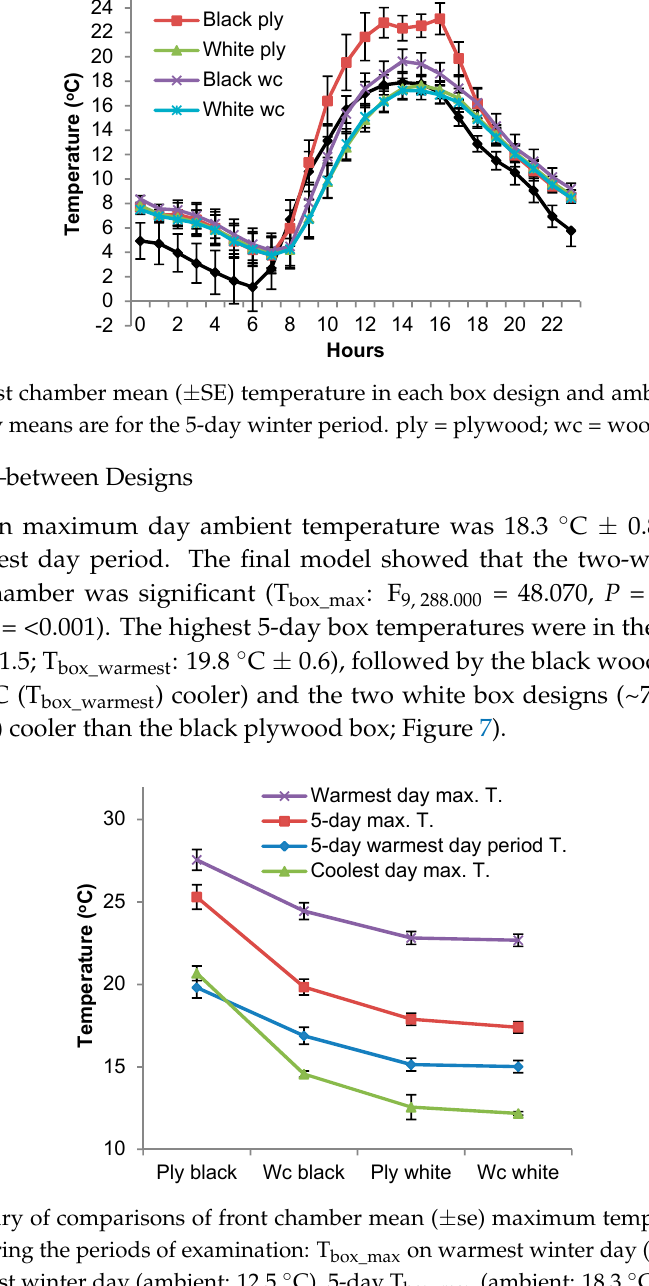
Figure 5. Percentage of chambers where chamber temperatures during T box_warmest (left) and T box_max (right) reached >30.0 °C (white bars), >35 °C (black bars) and >40 °C (red bars) during the 32-day monitoring period (5 February–8 March 2015). X-axis: 1 = front chamber; 2 = second chamber; 3 = third chamber; 4 = back chamber; ply = plywood; wc = wood-cement.